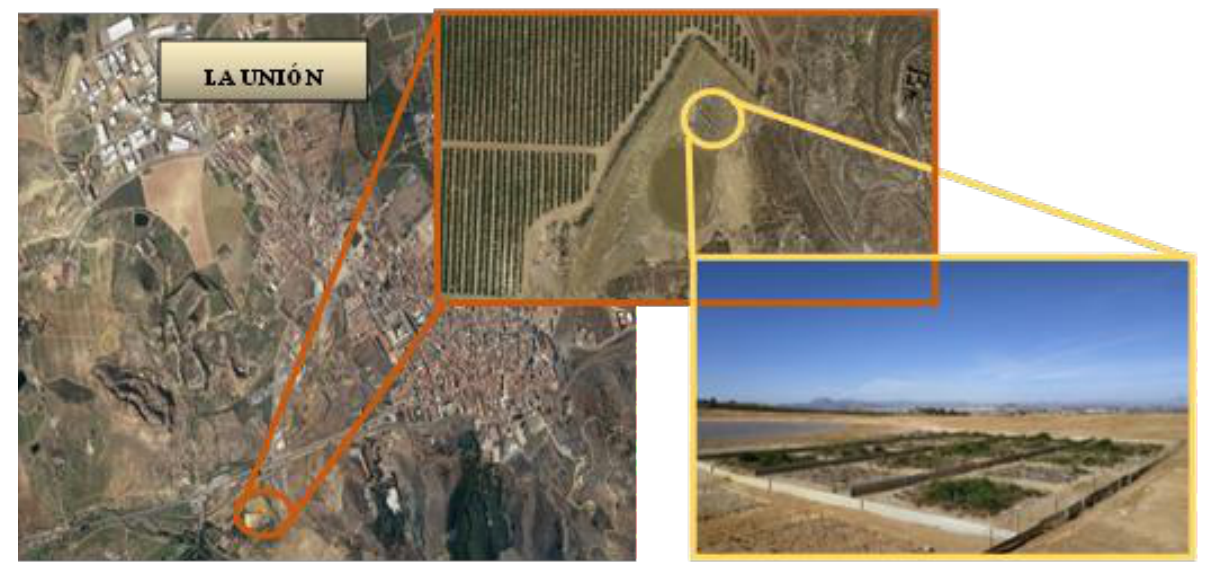
Figure 2. Detail of the experimental plots.